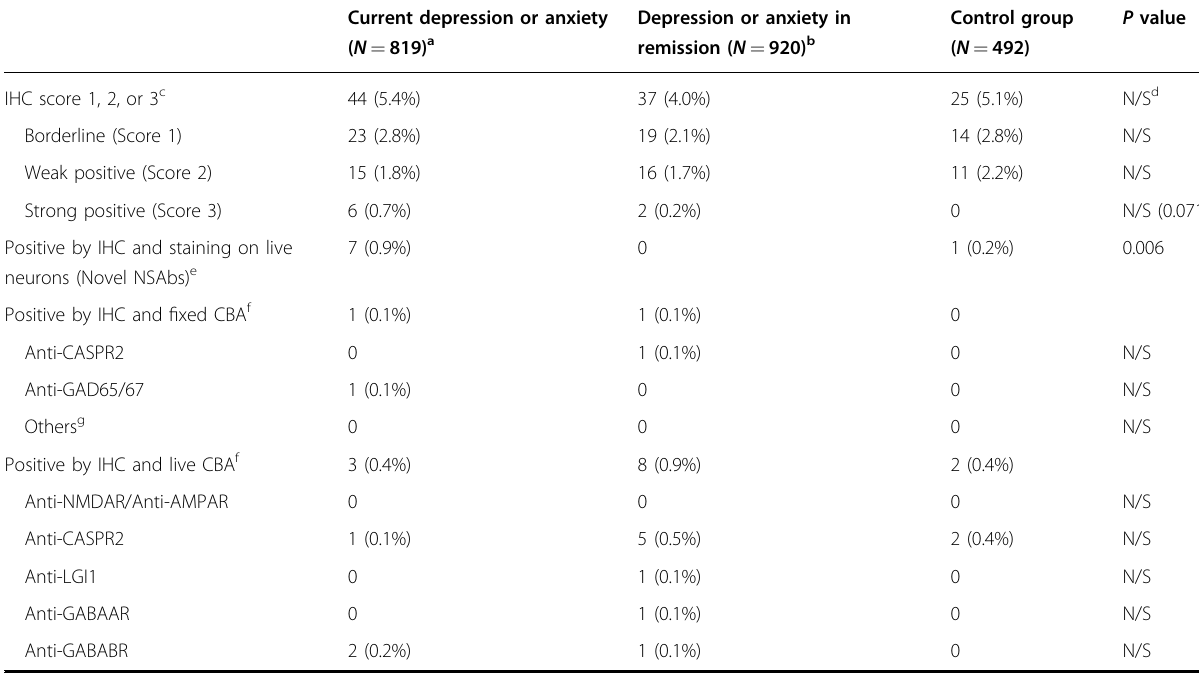
Table 2 Prevalence of neuronal autoantibodies in the 2231 NESDA